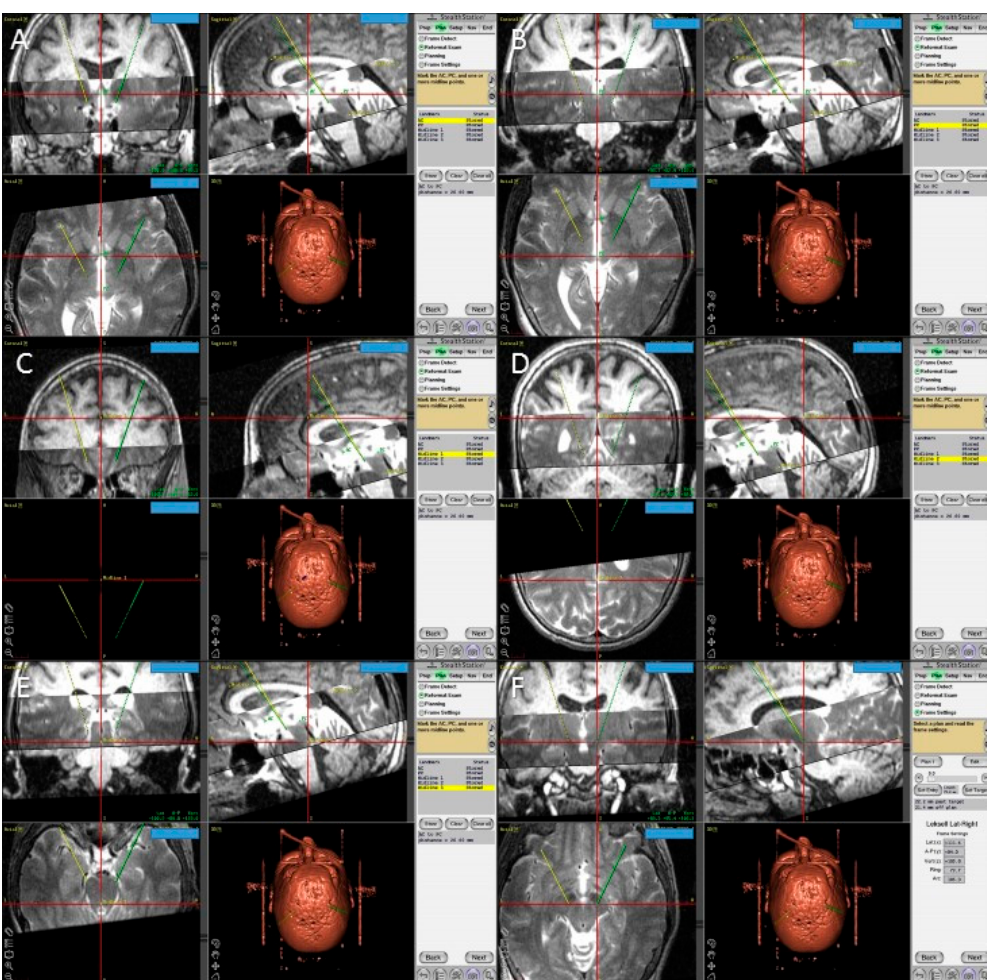
Figure 5. Screen shots from the Framelink software of the Stealthstation showing fused T1 and T2 MRI images of the patient and the planning process with identification of the posterior edge of the anterior commissure (AC) ( A ); the anterior edge of the posterior commissure (PC) ( B ); three midline points ( C – E ); and the final coordinates of the right subthalamic nucleus ( F ).